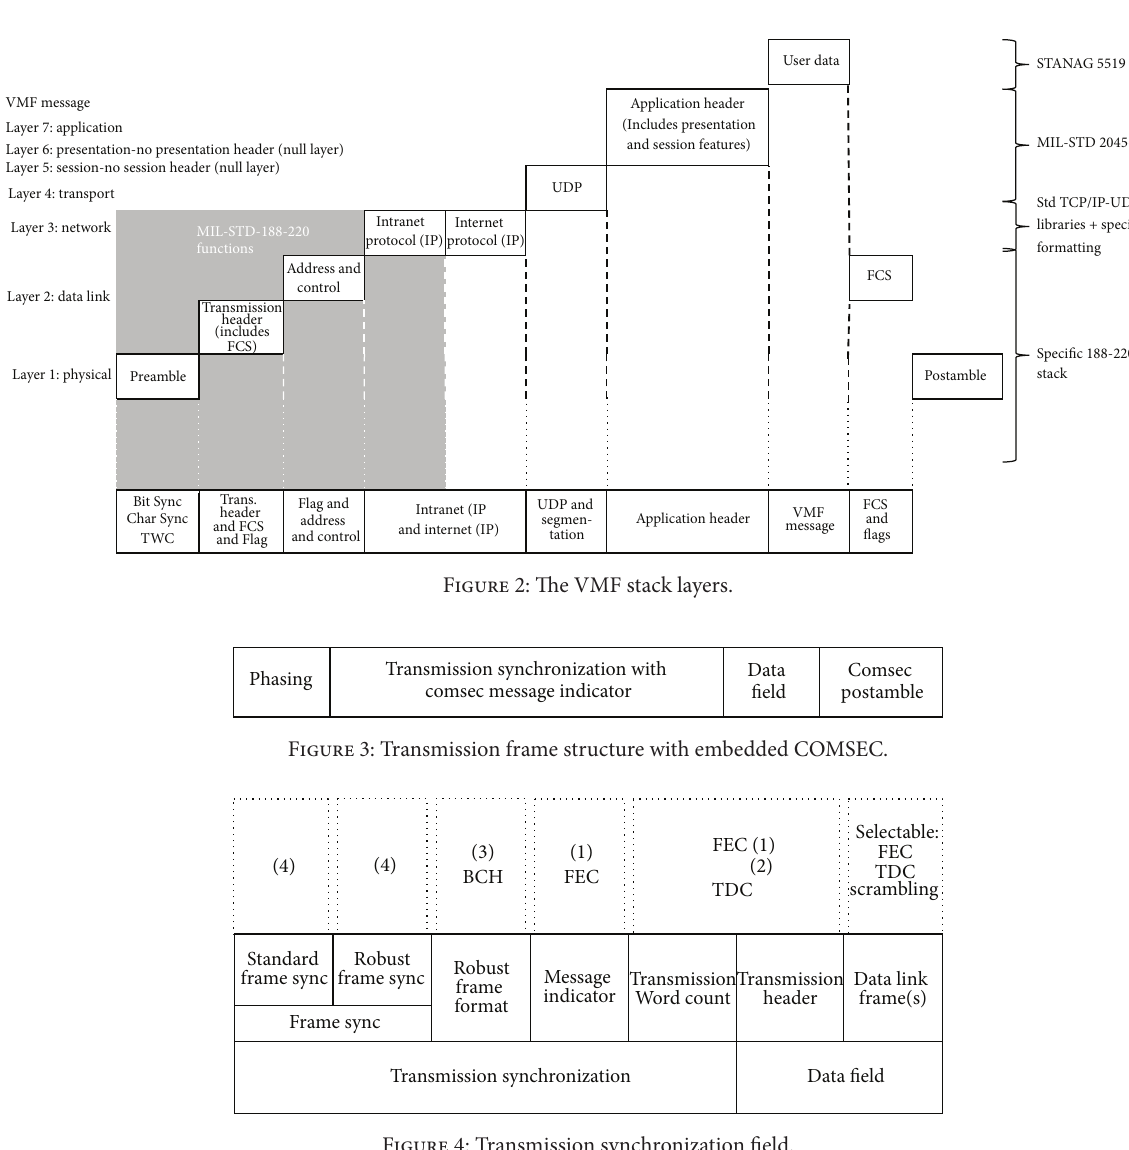
Figure 4: Transmission synchronization